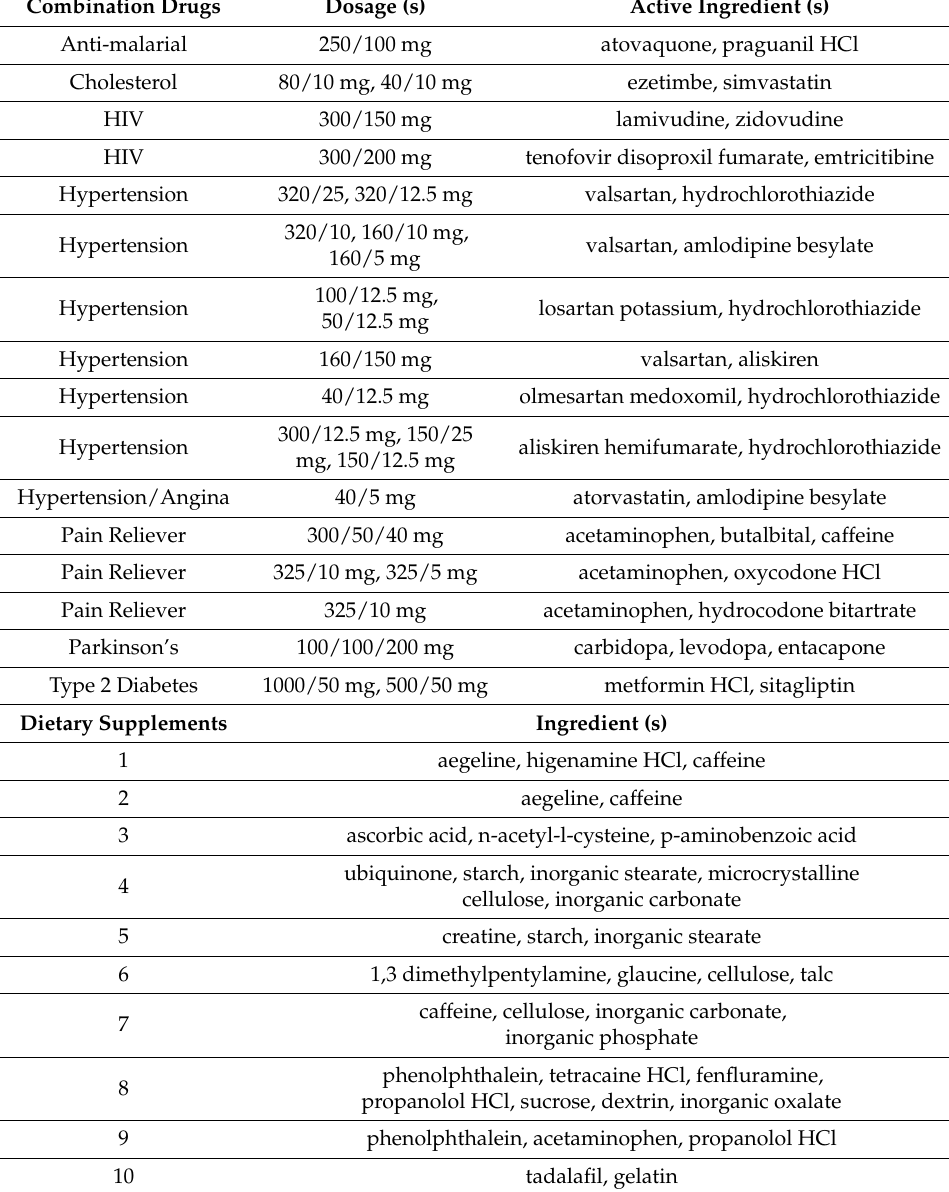
Table 1. Combination drugs and multi- active pharmaceutical ingredient (API) dietary supplements examined by the Forensic Chemistry Center (FCC) using FT-IR spectroscopic